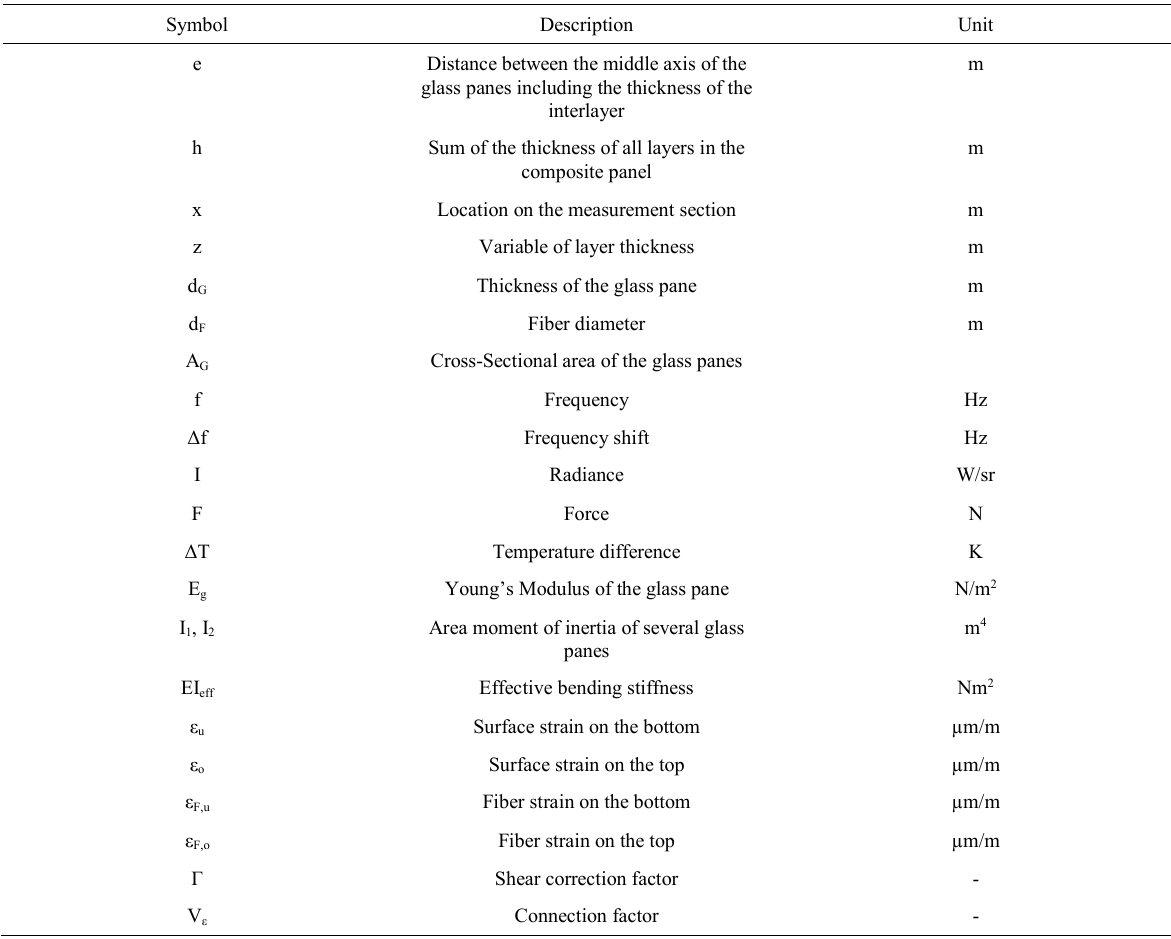
Table 1: Symbols used in the